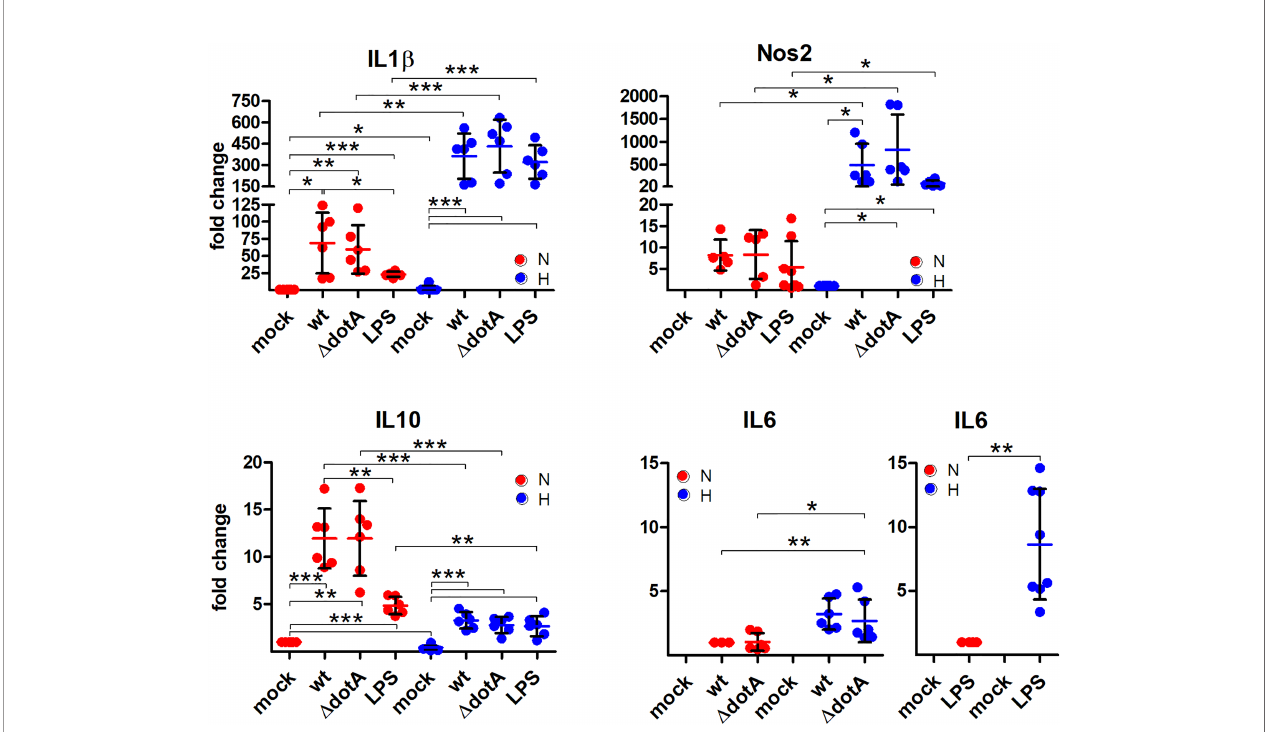
FIGURE 8 | A pro-in fl ammatory pro fi le is observed through C. burnetii infection under hypoxia. BMDM were either uninfected (mock), infected with C. burnetii (wt), the T4SS transposon mutant ( D dotA ), or treated with LPS (100 ng/ml) for 24 h under normoxia (N) and hypoxia (H). Using qRT-PCR, the gene expression of murine IL1 b , Nos2 , IL10 , and IL6 was analyzed. The data are plotted as Mean ± SD of 2^- DD CT values (using murine HPRT as a calibrator). In case of IL1 b and IL10 , fold changes are shown relative to uninfected cells under N, while for Nos2 they are represented relative to uninfected cells under H. For IL6 , fold changes are shown relative to wt-infected cells or LPS-treated cells under N. The data shown for each of the C. burnetii (wt and D dotA ) infection experiments and the LPS treatment experiment represent 3 independent experiments with biological duplicates. One sample t test or t test, n=5-6. ***p < 0.001, **p < 0.01, *p <